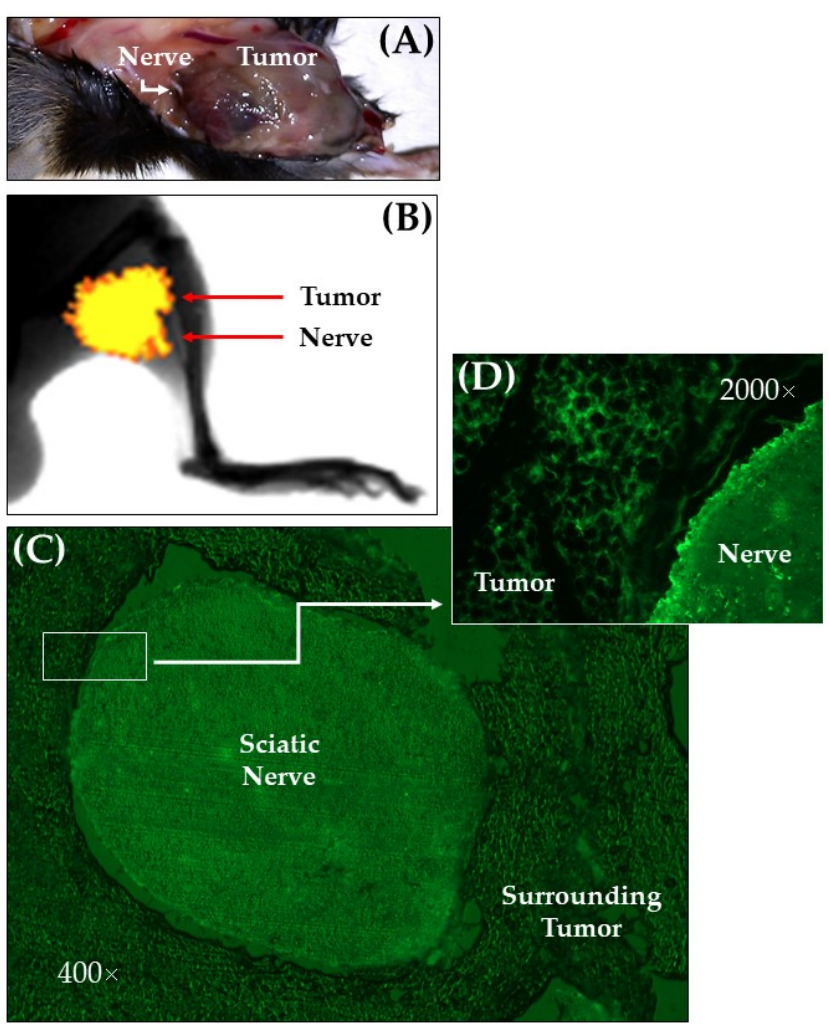
Figure 1. Tumor–nerve details: ( A ) Tumor mass engulfing the sciatic nerve. ( B ) In vivo image showing the tumor fluorescence signal co-registered with an anatomical X-ray plane of the inoculated hind paw. ( C ) Fluorescent microscope image (400×) of a transversal section of the sciatic nerve surrounded by the tumor. ( D ) Insert at higher magnification (2000×) showing the fluorescent B16–BL6/Zs green cells around the sciatic nerve. Images were taken 17 days after inoculation of the cell line (endpoint).